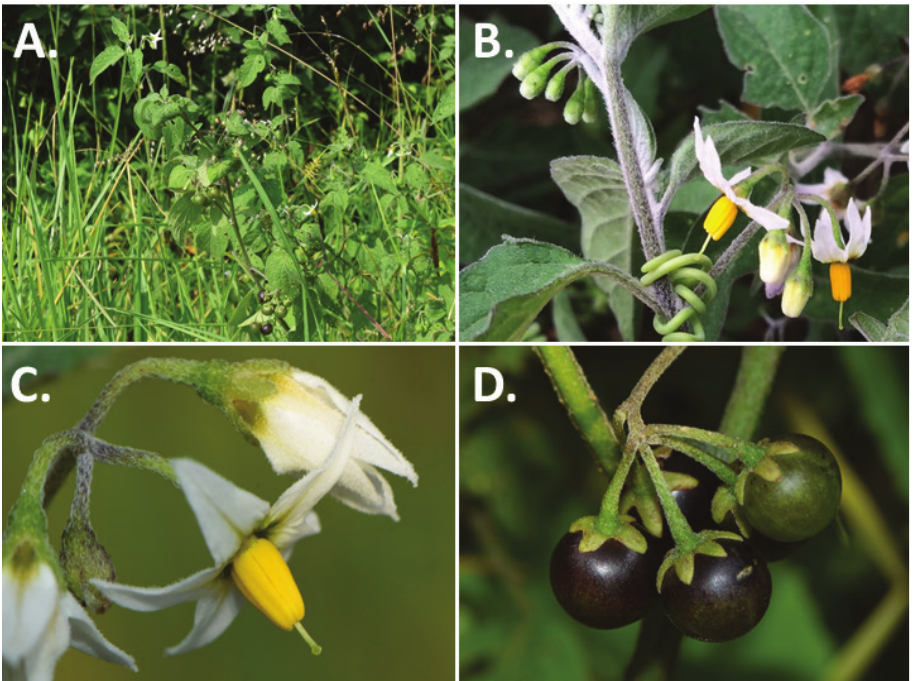
Figure 13. Solanum douglasii Dunal A Habit B young and maturing inflorescences with buds and flow- ers C flowers at full anthesis D fully mature matte black fruits with appressed calyx lobes ( A–D Ochoter- ena et al. 979 ). Photos by S.